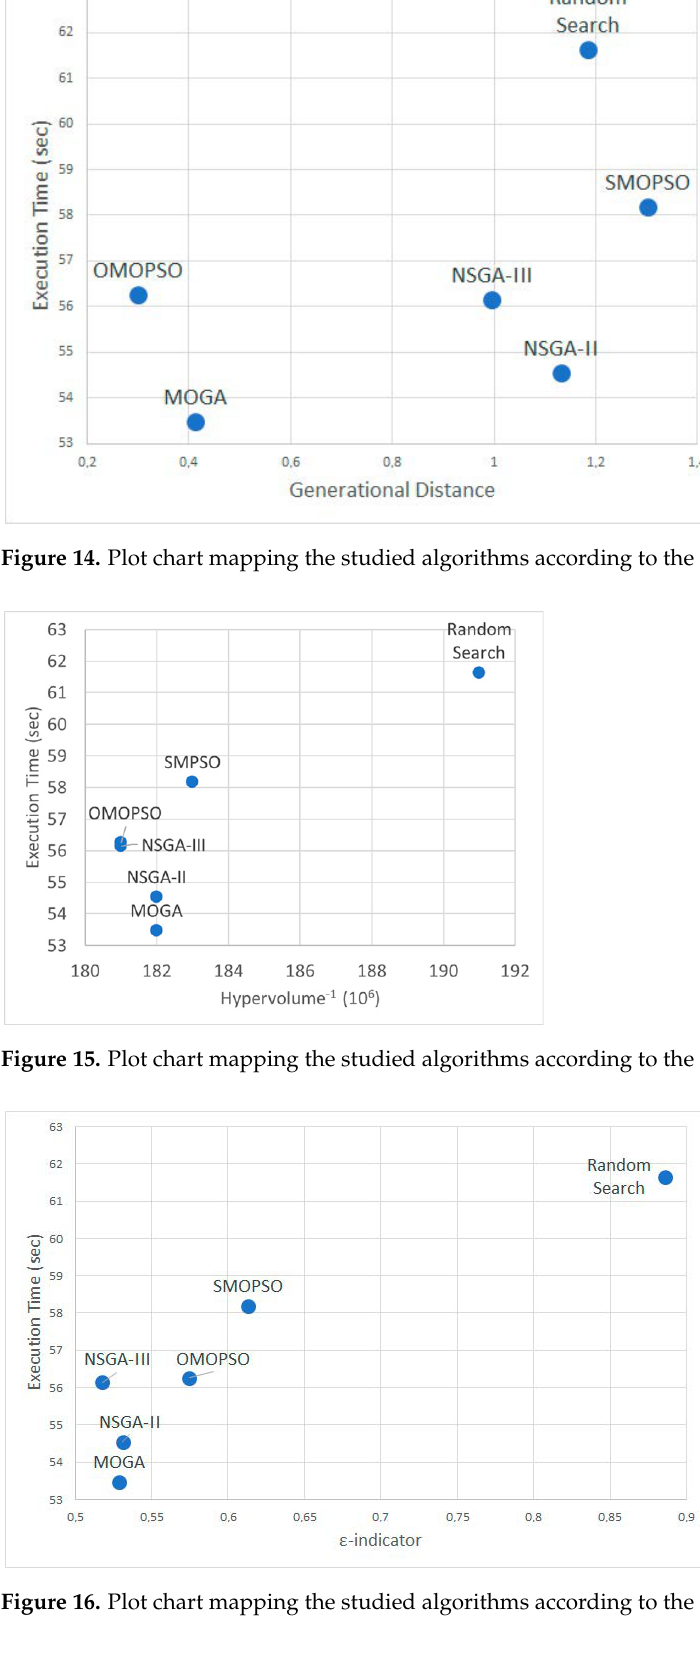
Figure 16. Plot chart mapping the studied algorithms according to the ET and the ε -Indicator.